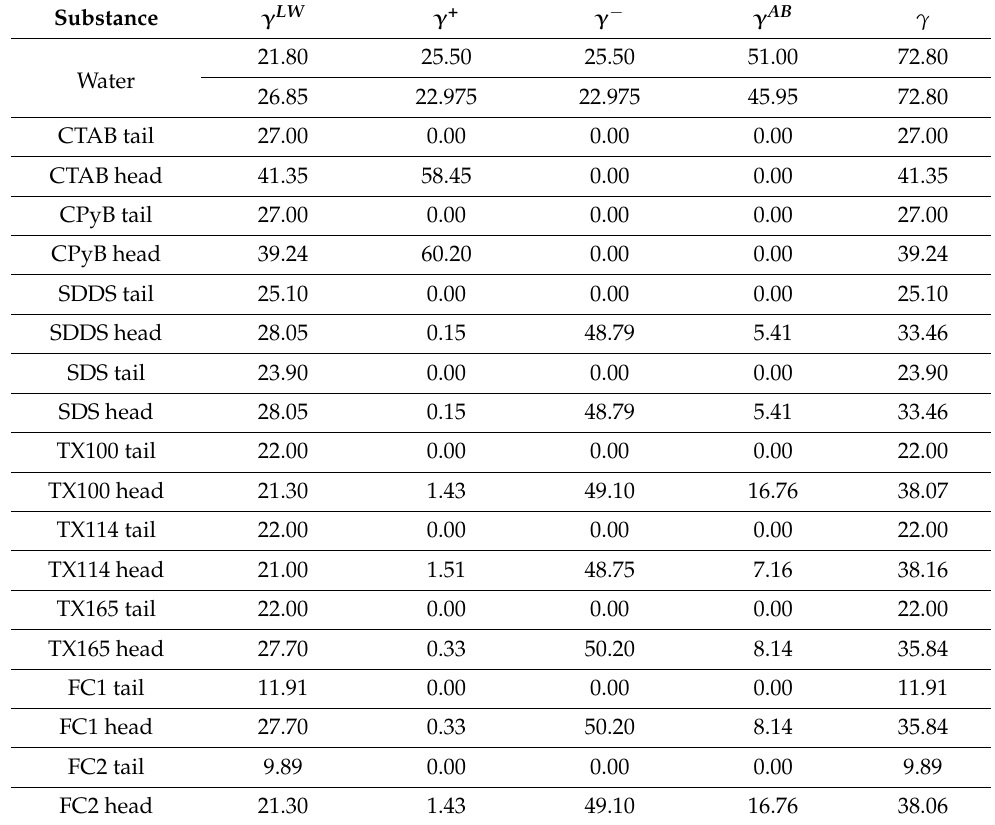
Table 1. The components and parameters of the surface tension of water, CTAB, CPyB, SDS,